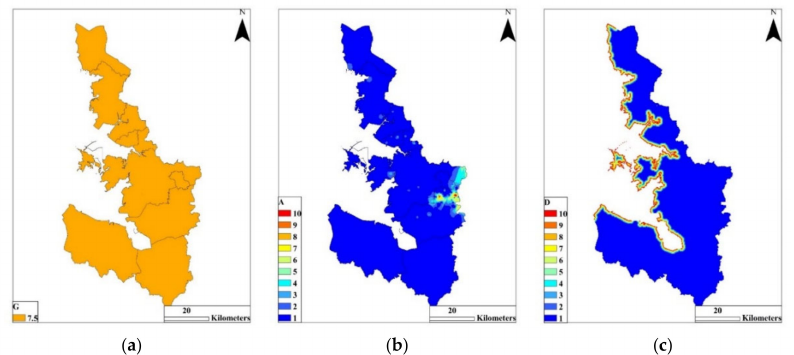
Figure 5. Thematic maps of static parameters’ rating for ( a ) groundwater occurrence, G, ( b ) aquifer hydraulic conductivity, A, and ( c ) distance from shore,